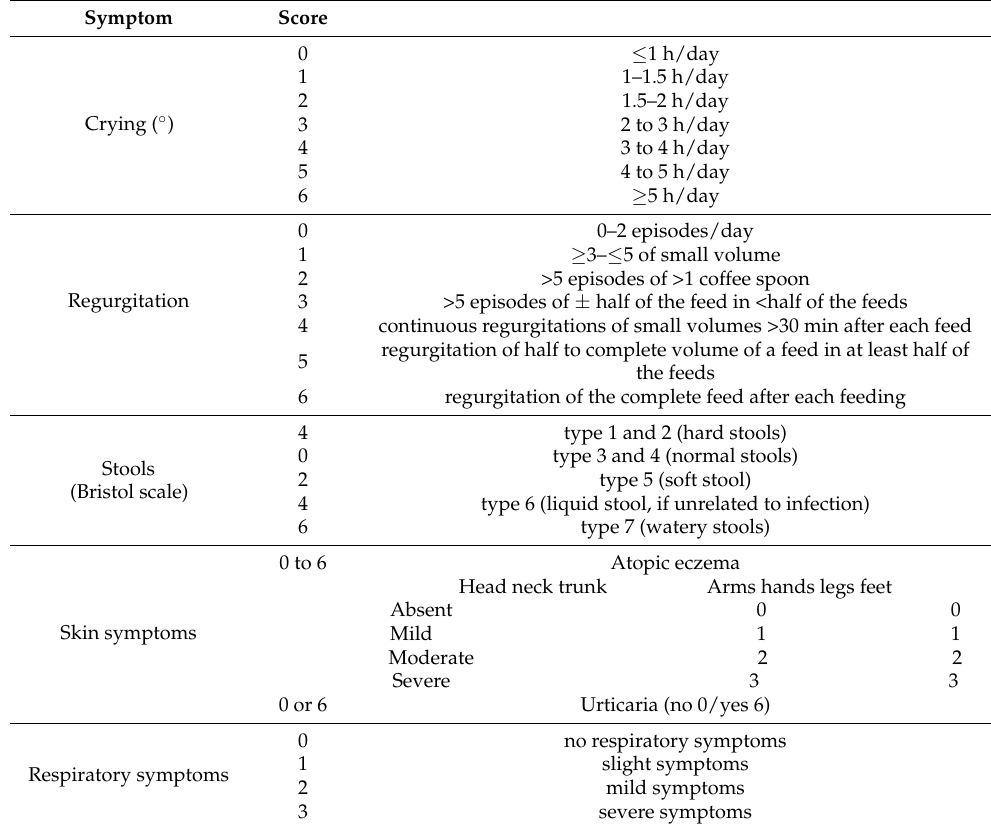
Table 1. Symptom-based-score and CoMiSS (adapted from Refs